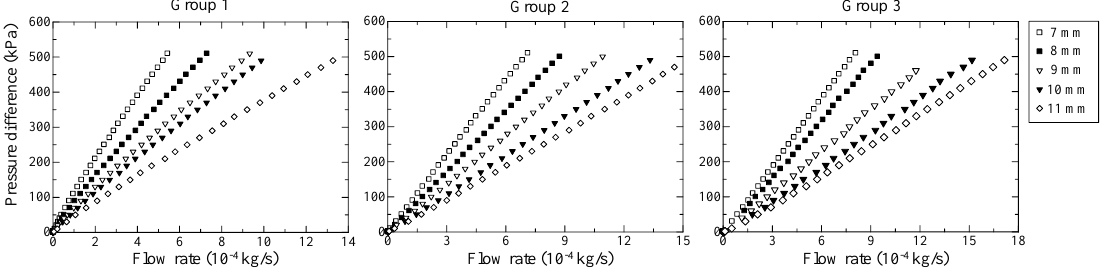
Figure 6. Variation of measured pressure difference with mass flow rate.